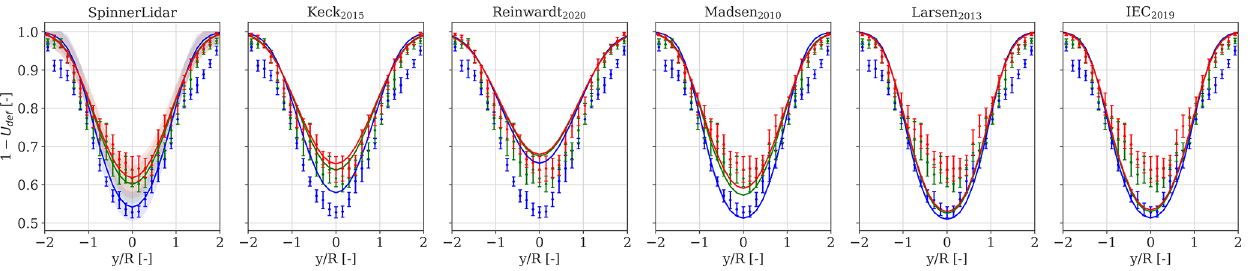
Figure 9. Ensemble-average spanwise velocity deficit profiles computed in the MFoR at hub height obtained at 5 D behind the rotor for an incoming wind speed of 7m/s under stable (blue), near-neutral (green), and unstable (red) atmospheric conditions. The measured turbulence intensities are 7%, 12%, and 16%, respectively. The SpinnerLidar-measured profiles are shown by markers and their relative 95% confi- dence interval by the error bars. The DWM-model-predicted deficits are shown by solid lines; each panel refers to model predictions using calibration parameters from a number of studies (see text for more details). The “SpinnerLidar” panel refers to the model proposed in the current study, while the shaded areas indicate its 95% confidence interval.